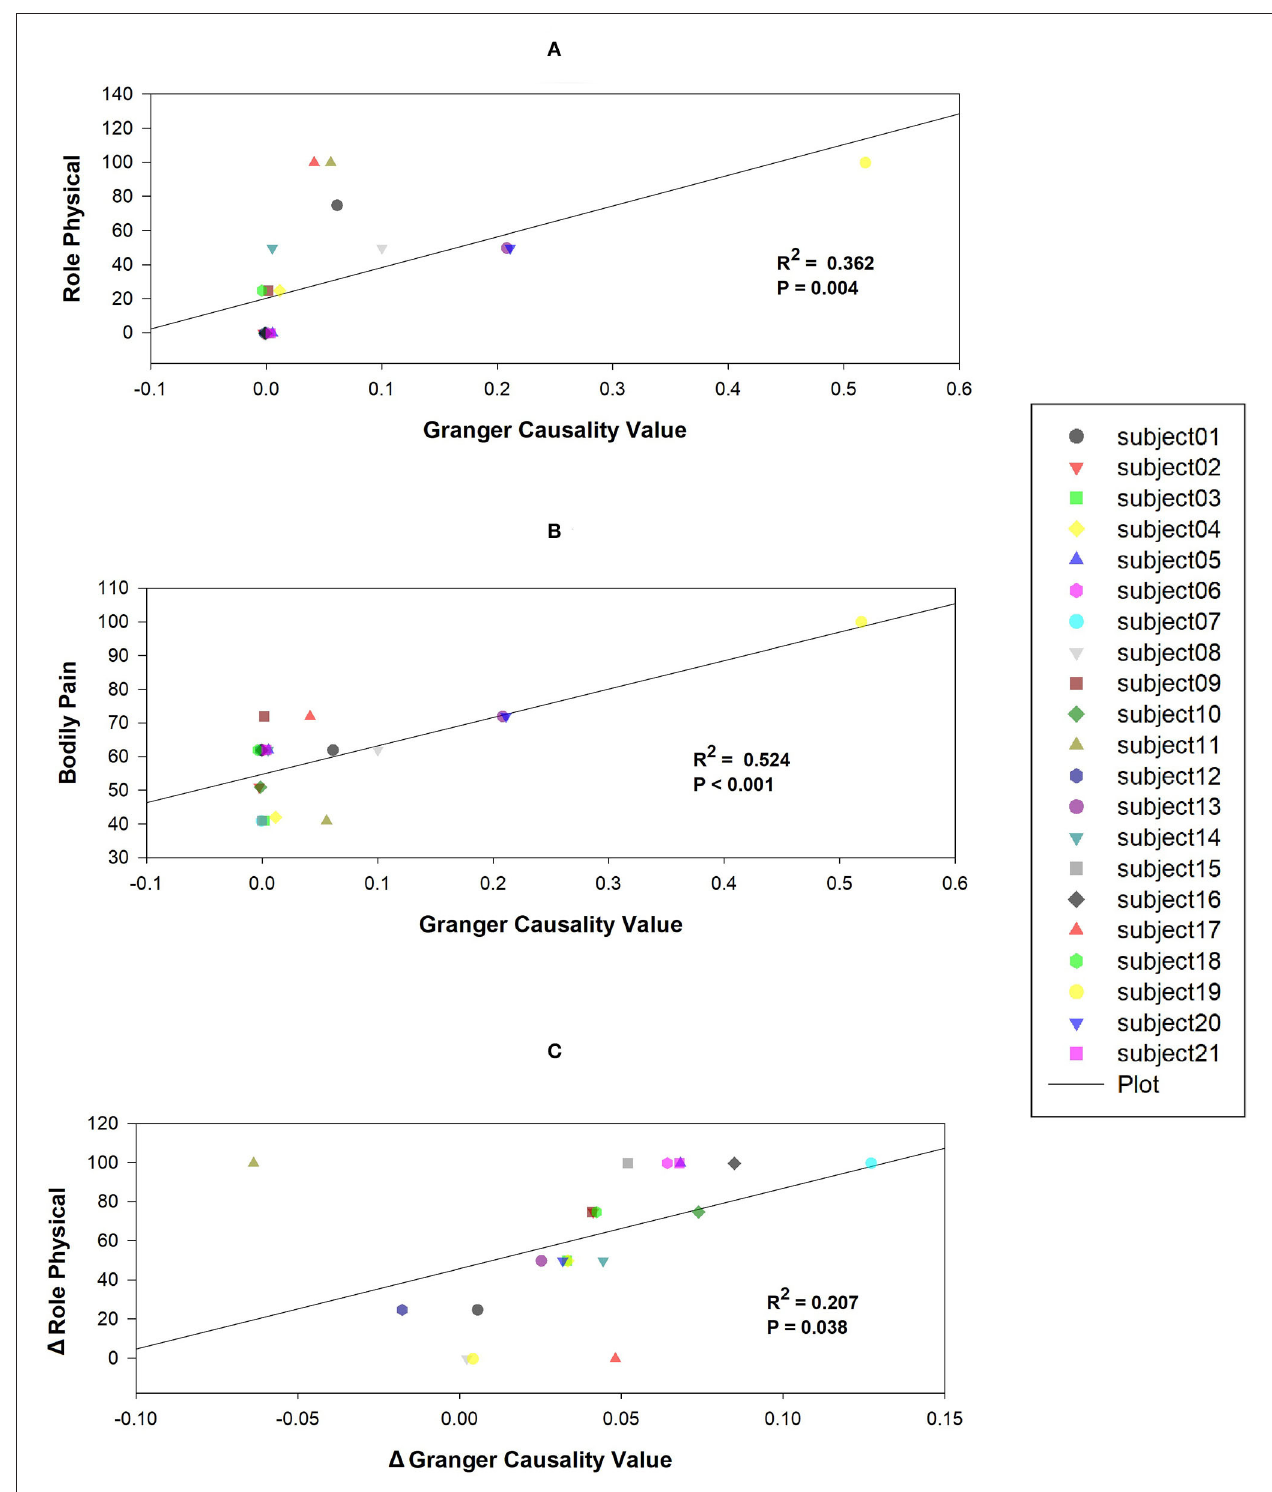
FIGURE 5 | Correlations between mean Granger causality values within abnormal casual connectivity and the scores of Role Physical and Bodily Pain. (A) The mean Granger causality values from SMN to DMN were positively associated with the score of Role Physical ( R 2 = 0.362, P = 0.004). (B) The mean Granger causality values from SMN to DMN were positively associated with the score of Bodily Pain ( R 2 = 0.524, P < 0.001). (C) The mean Granger causality difference from SMN to DMN was positively associated with the score of Role Physical difference ( R 2 = 0.207, P = 0.038).